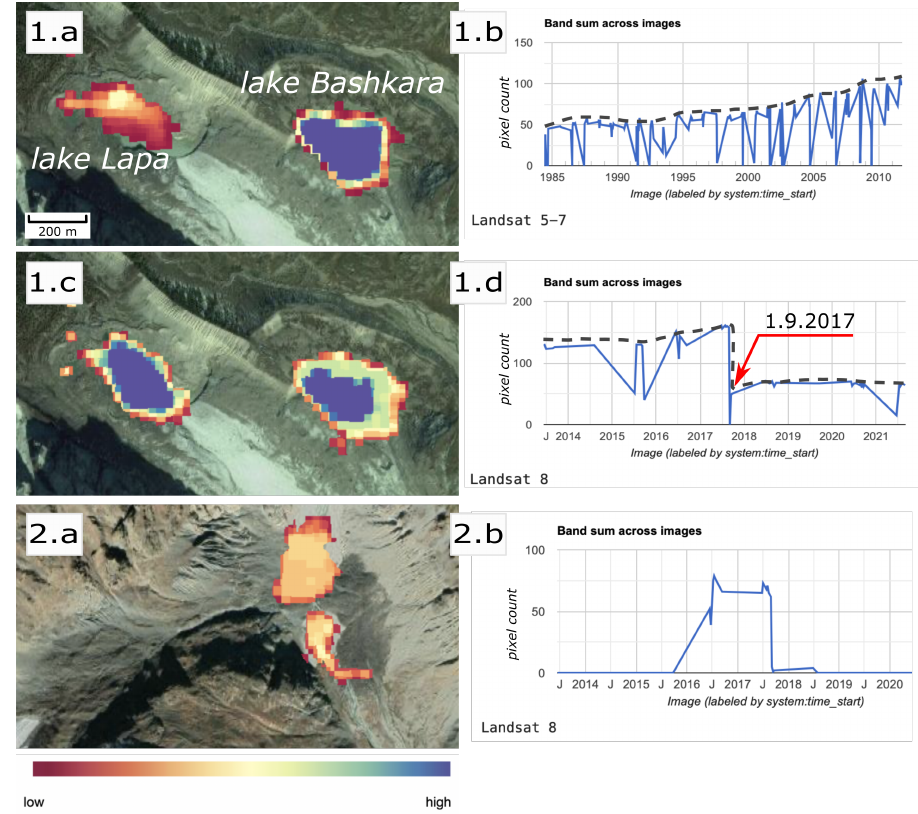
Figure 3. Bashkara glacial lakes, Central Caucasus (43 ◦ 12’N, 42 ◦ 44’E), background image—Google Earth. ( 1.a ) Water occurrence/frequency map (how many times pixels are classified as water), source data: Landsat 5 and 7; ( 1.b ) time-series of the Bashkara lakes area changes, source data: Landsat 5 and 7; ( 1.c ) Water occurrence/frequency map, source data: Landsat 8; ( 1.d ) time-series of the Bashkara lakes area changes, the lake Bashkara burst out on 1.9.2017 [49], source data: Landsat 8; The dashed black line corresponds to the actual area changes of the lakes, as an envelope of the local maximum area values; ( 2.a ) Water occurrence/frequency map of an unnamed landslide-dammed lake (43 ◦ 06’N, 42 ◦ 52’E); ( 2.b ) time-series of its area changes. For the location of the example in an overview map see Figure